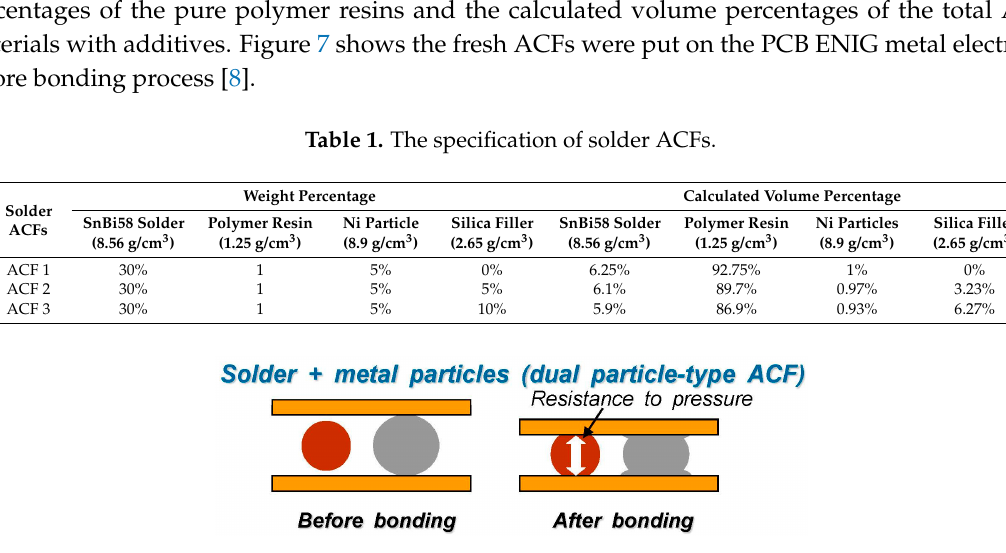
Figure 5. 500- μ m-pitch flex-on-board (FOB) test vehicles. ( a ) printed circuit board (PCB), ( b ) polyimide based flexible printed circuit (FPCB).